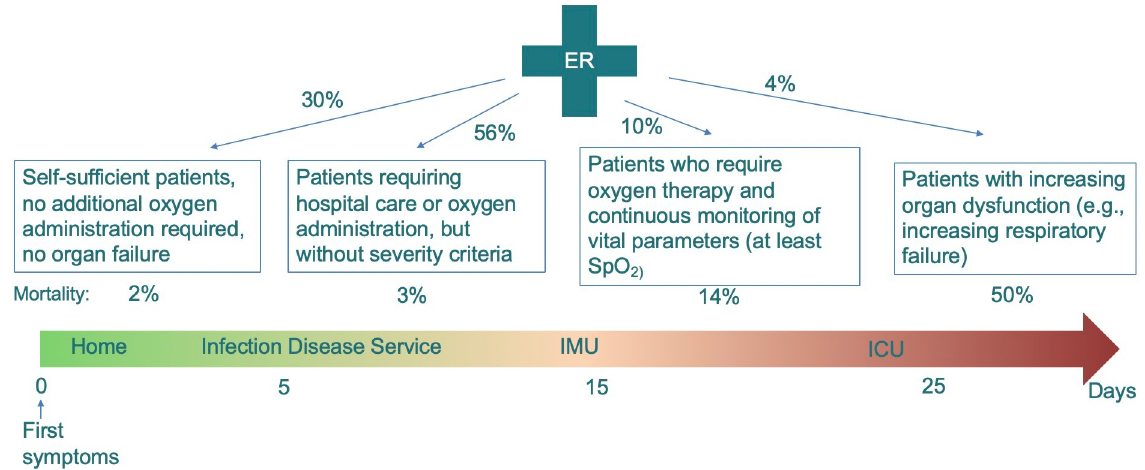
Fig 2. Disease progression—see references [11, 12].